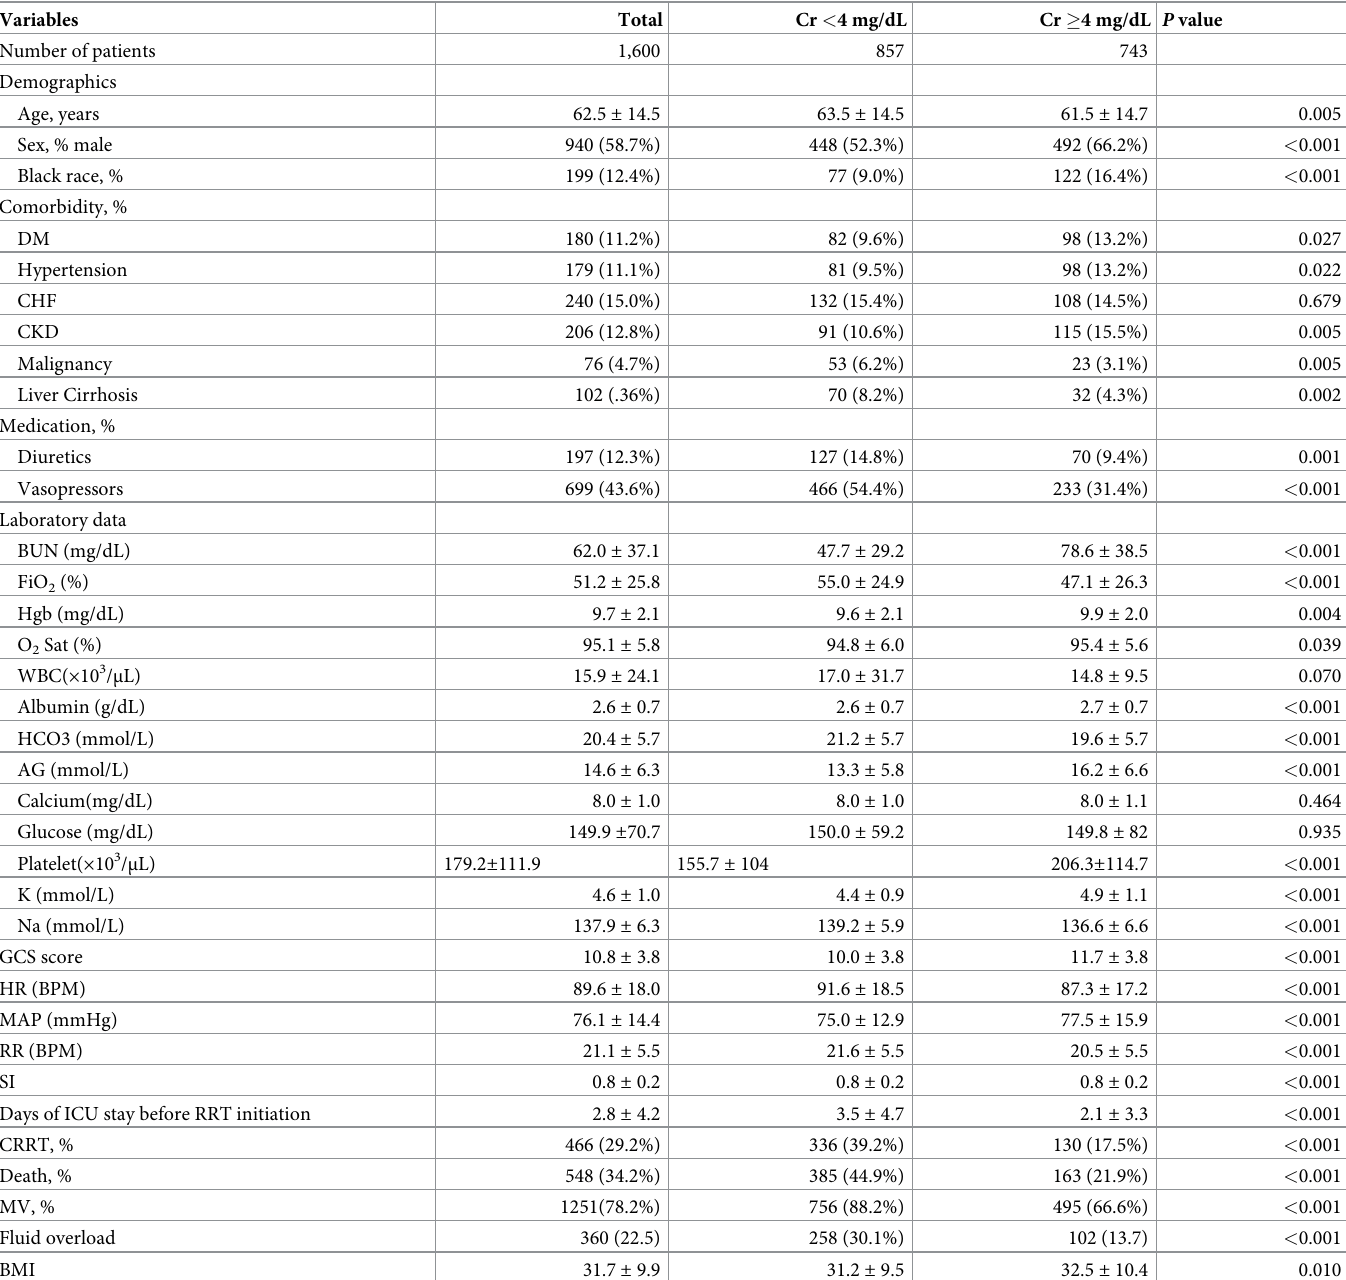
Table 1. Baseline characteristics of the study population by the median of creatinine